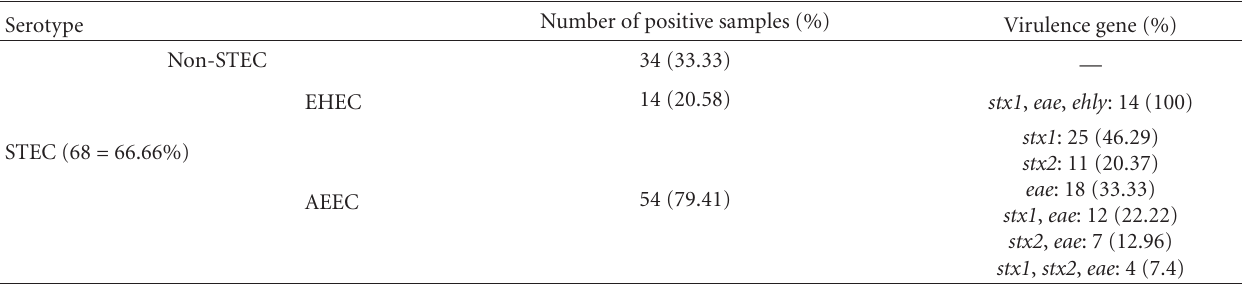
Table 5: Prevalence of virulence genes in Shiga toxin-producing E. coli serotypes isolated from raw animal milk samples and traditional dairy products in Iran. Serotype